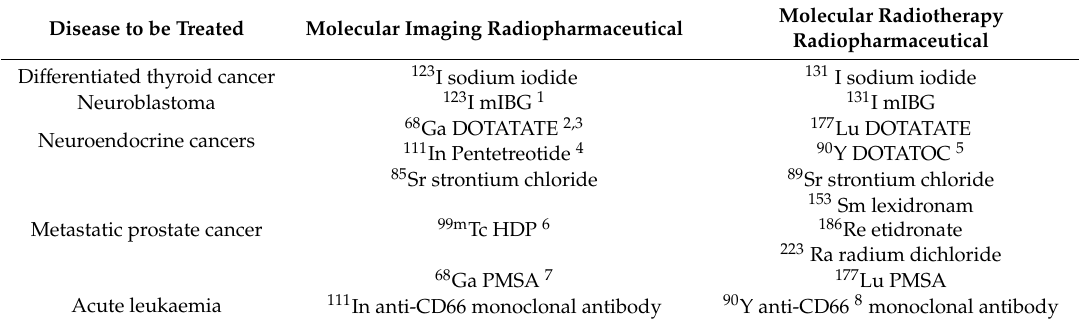
Table 1. Examples of pairs of theragnostic